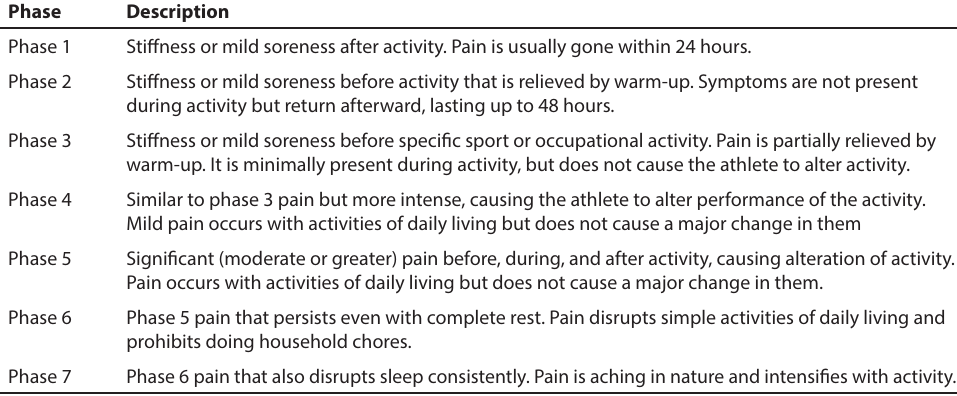
TABLE 2. Nirschl Pain Phase Scale of Athletic Overuse Injuries (O’Connor et al.,